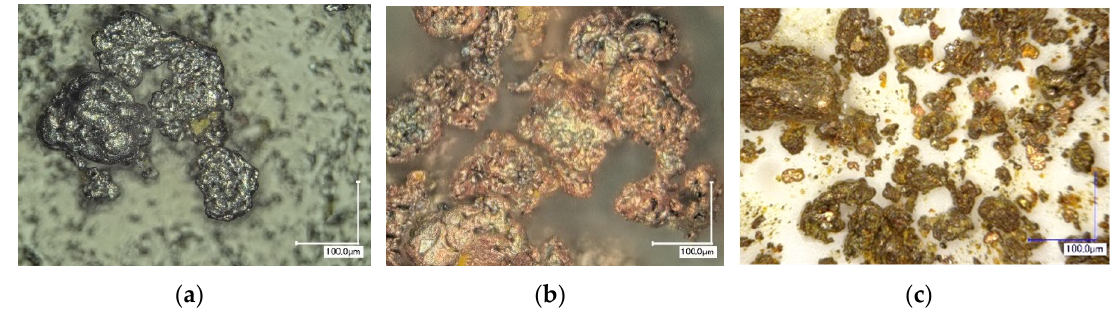
Figure 6. ( a ) NC 100.24 Fe powder particles before cementation; ( b ) NC 100.24 Fe powder particles after cementation at 10th minute, without cavitation treatment; ( c ) NC 100.24 Fe powder particles after cementation at 10th minute, with cavitation treatment.